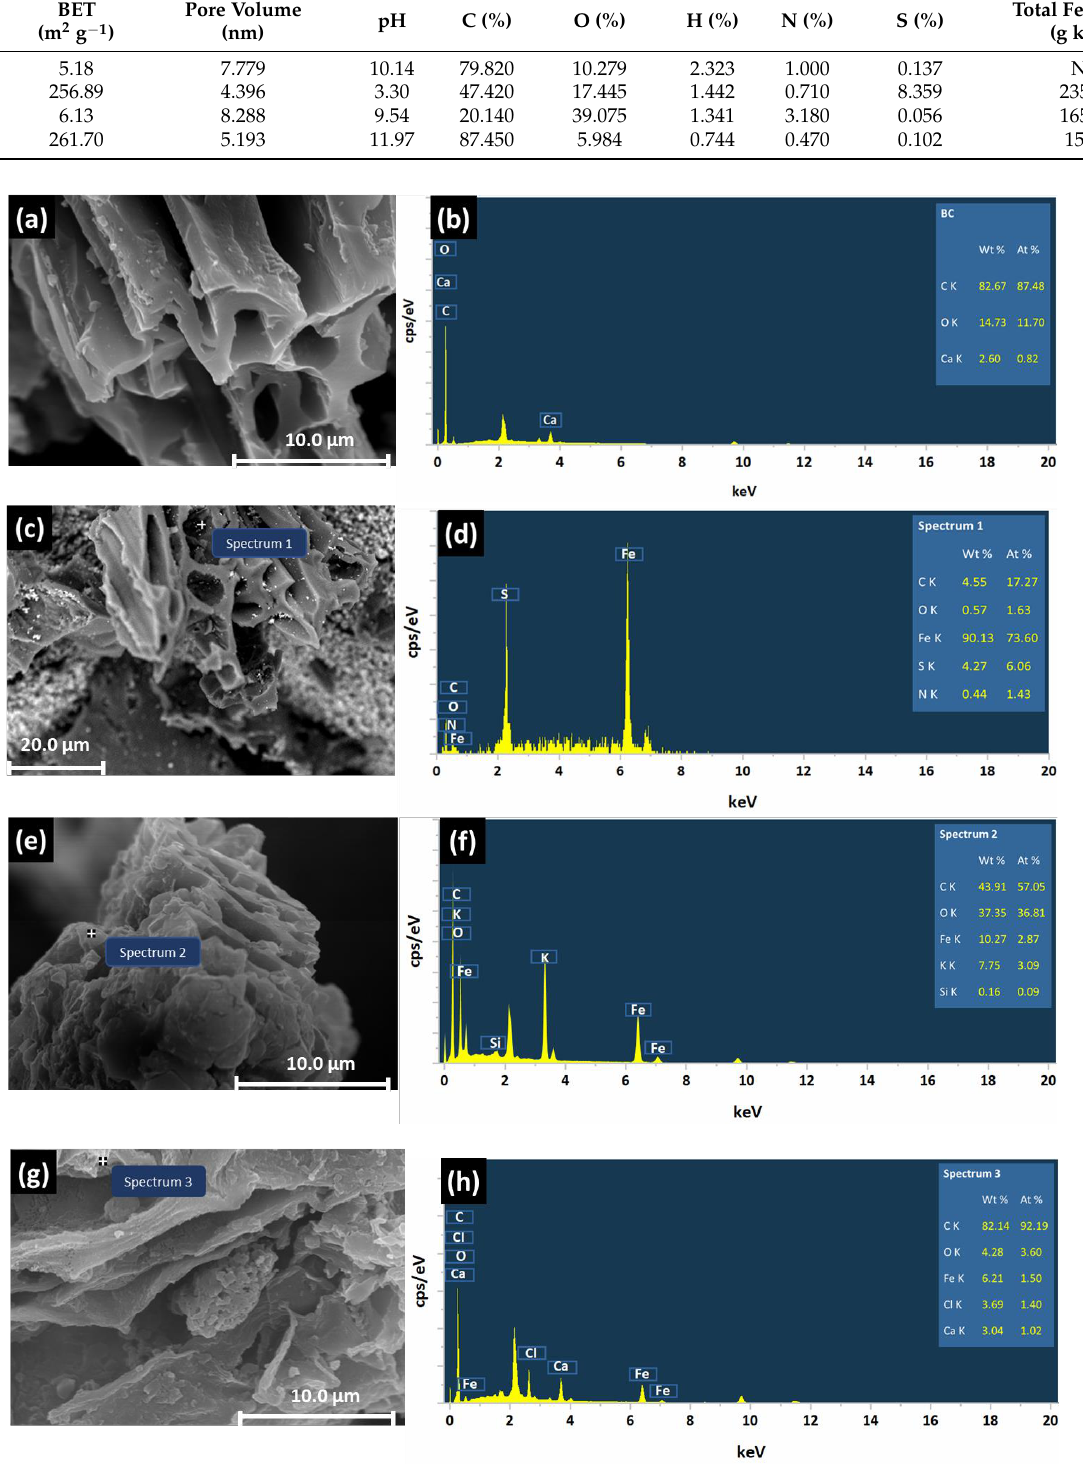
Figure 1. SEM-EDS images of BC, GBC, CSBC, and ZBC ( a – h ). Table 1. Physicochemical properties of BC, GBC, CSBC, and ZBC.